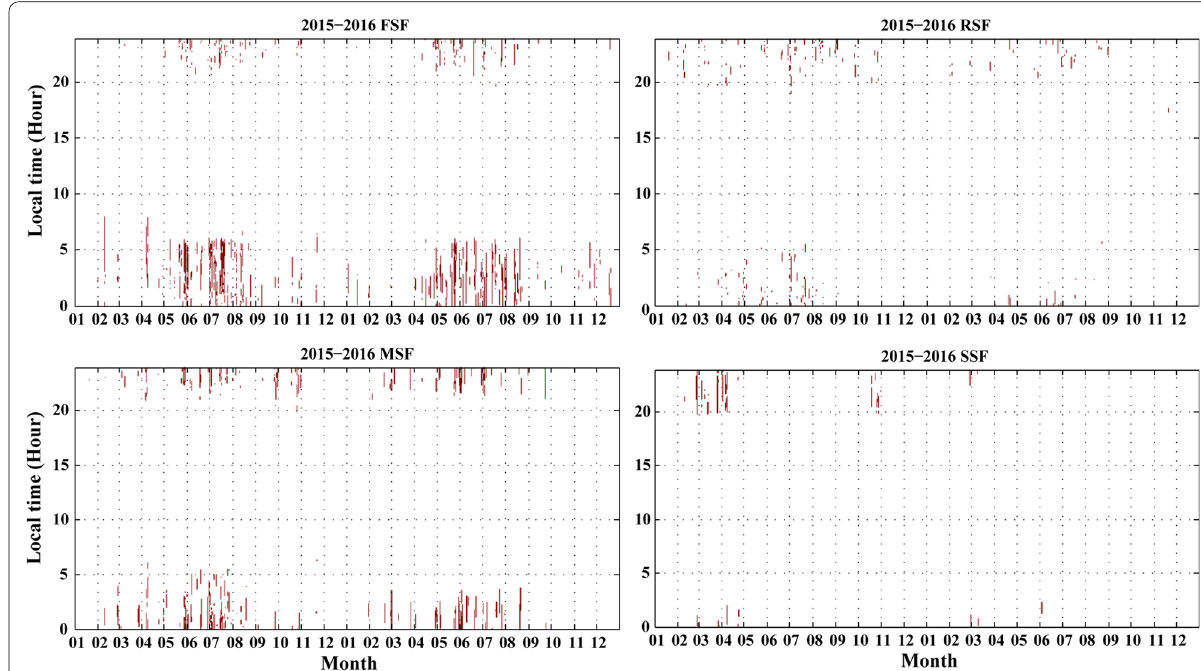
Fig. 4 The variation of SF occurrence time with days during the magnetic quiet conditions (Kp < 3) for 2015 (moderate solar activity year) and